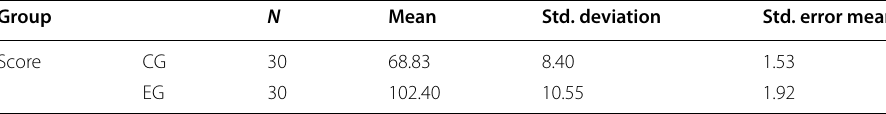
Table 18 Anxiety post‑test descriptive statistics Group N Mean Std. deviation